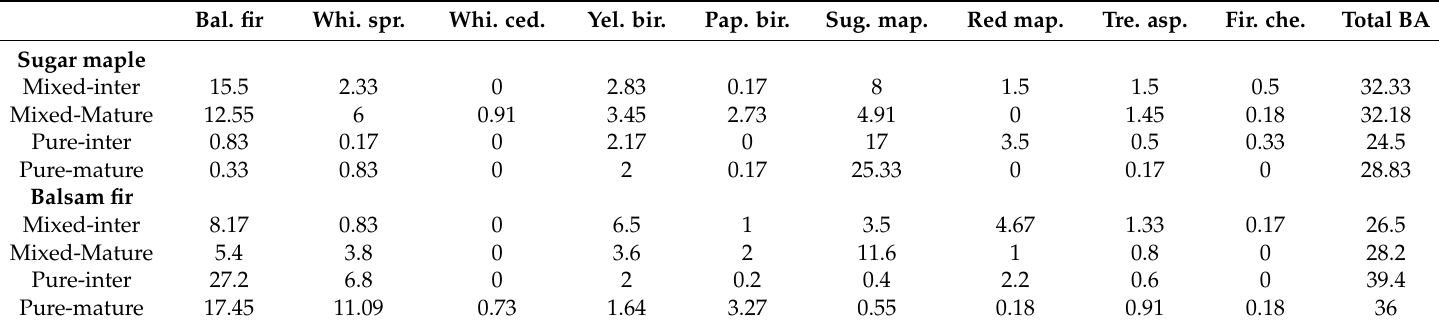
Table 2. Total and per species basal area (m 2 ha − 1 ) in pure and mixed stands for the two developmental stages. Bal. fir Whi. spr. Whi. ced. Yel. bir. Pap. bir. Sug. map. Red map. Tre. asp. Fir. che. Total